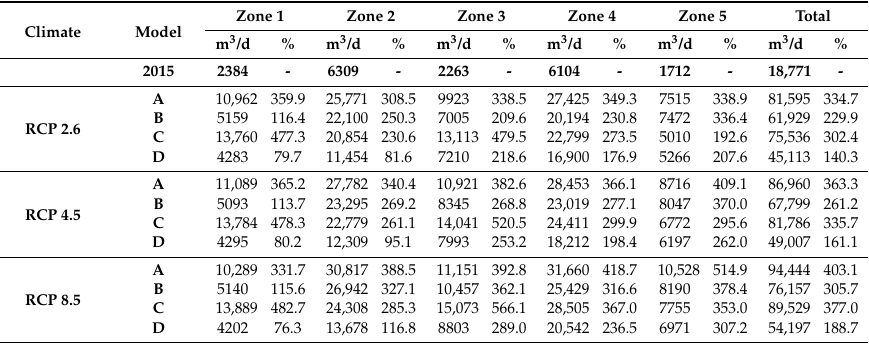
Table 7. Sustainable groundwater yields simulated from future climate scenarios and different conceptual models according to groundwater management